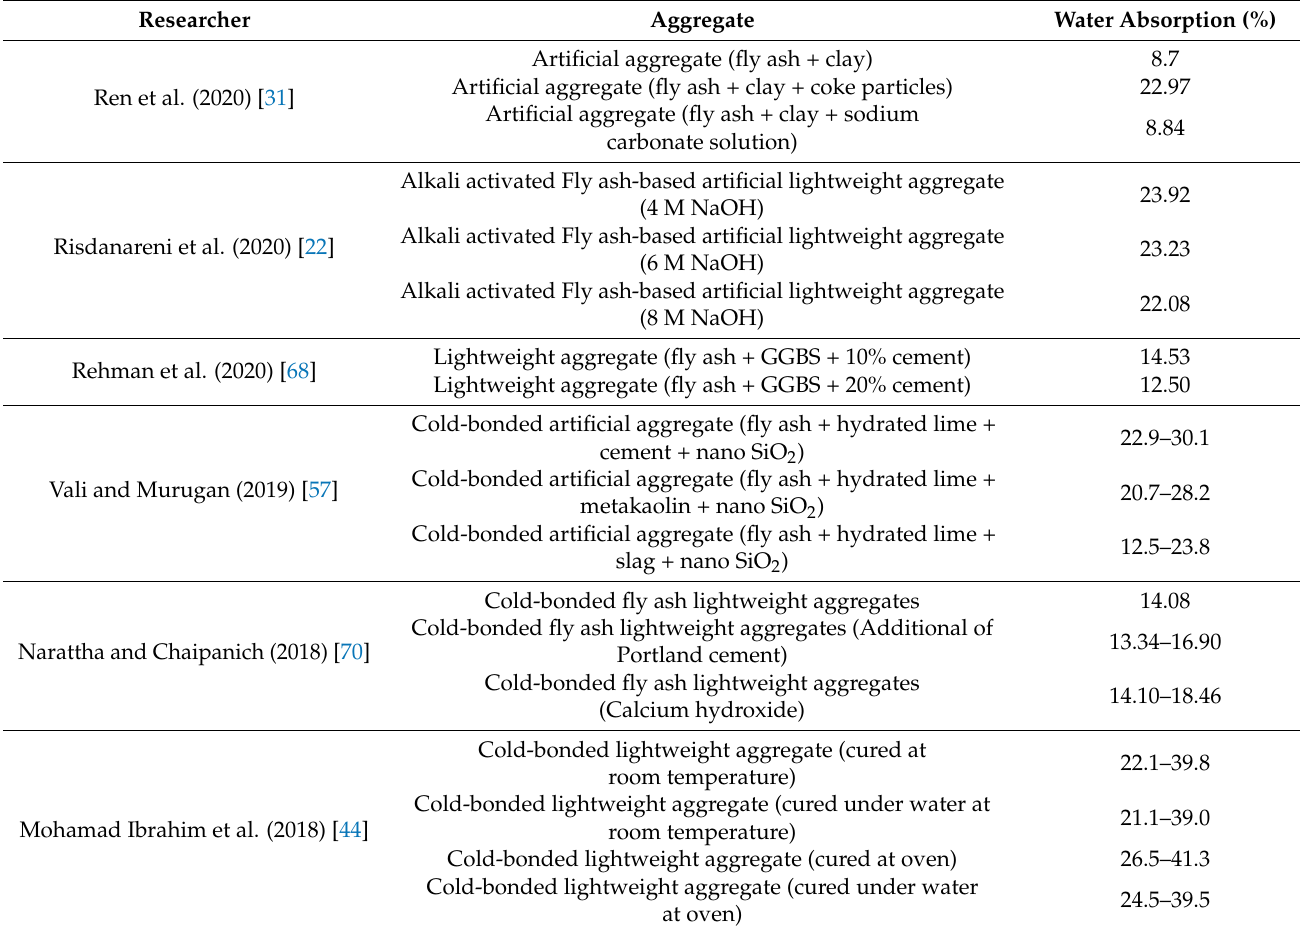
Table 3. Previous studies on water absorption of lightweight